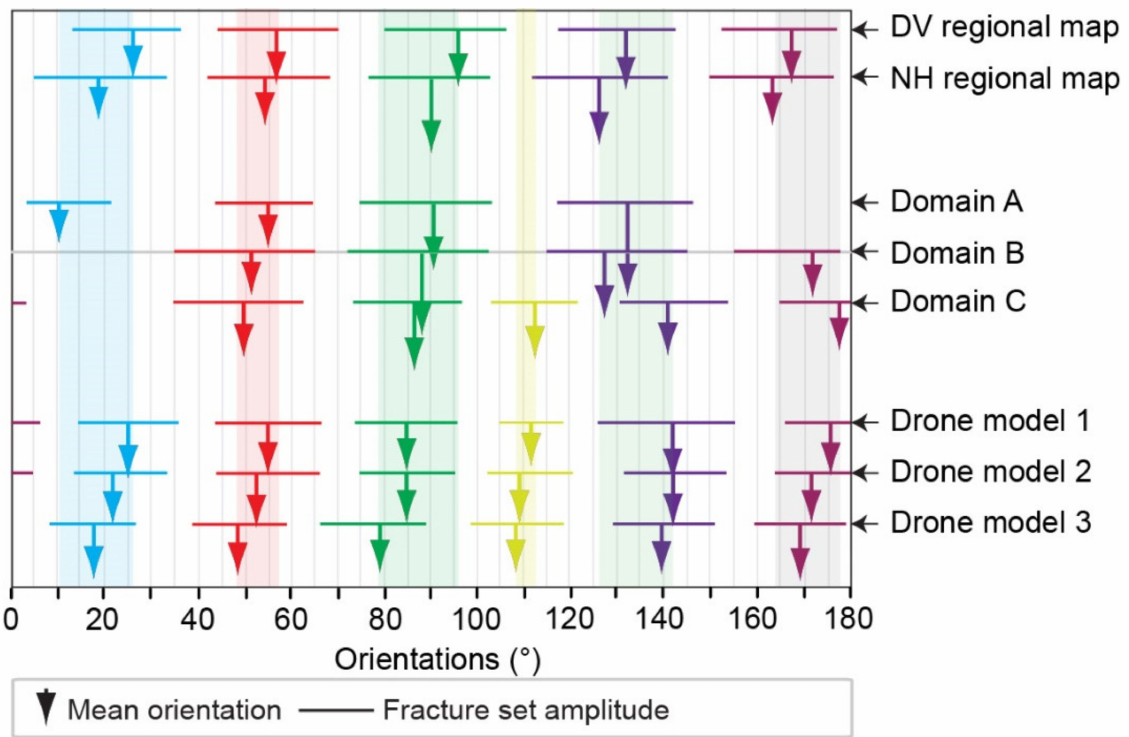
Figure 11. Orientation plot representing mean orientation of each fracture set from DV regional map, NH regional map, NH domains and drone models at outcrop scale. Each arrow corresponds to the mean orientation. The length of each arrow corresponds to the fracture set abundance. The horizontal line above each arrow corresponds to the fracture set standard deviation within an interval of confidence of 75% (see [62] for more explanations). Each color arrow corresponds to fracture set: Blue arrow corresponds to NNE/SSW fracture set, red arrow corresponds to the NE/SW fracture set, green arrow corresponds to the E/W fracture set, yellow arrow corresponds to the NNW/SSE fracture set, purple arrow corresponds to the NW/SE fracture set, and marron arrow corresponds to the N/S fracture